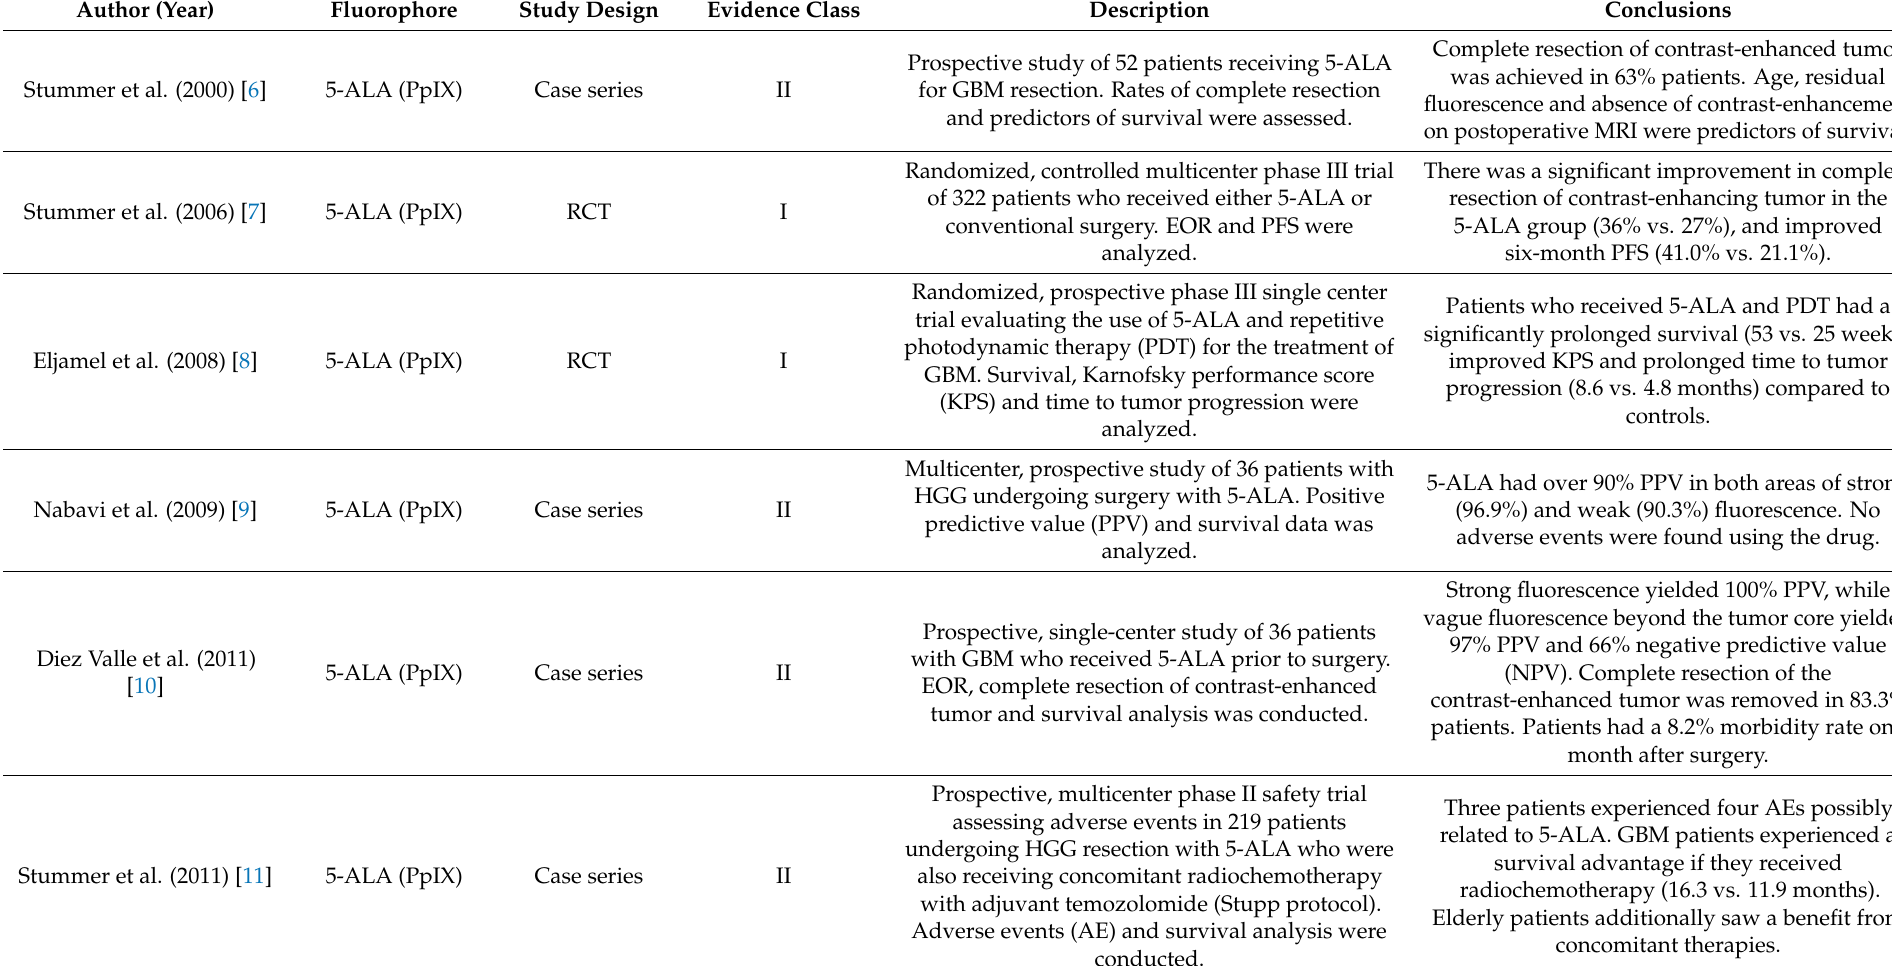
Table 1. Fluorescence-guided surgery for high-grade glioma evidentiary